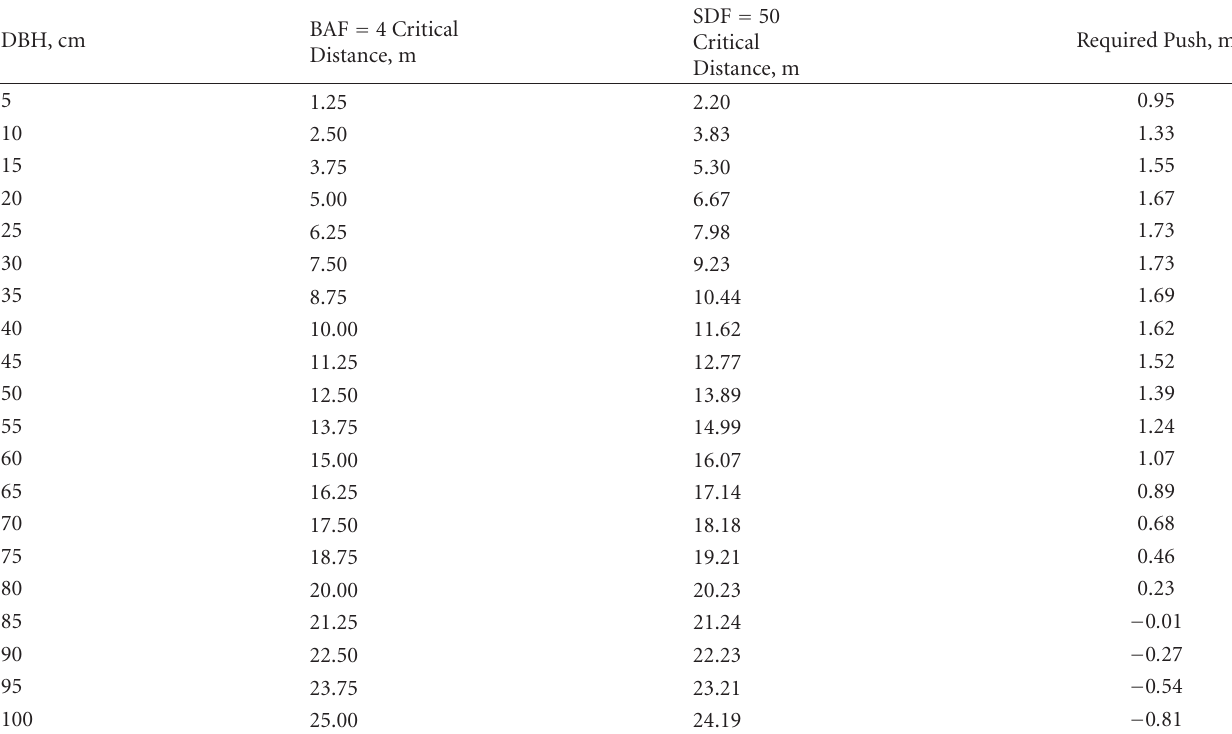
Figure 1: Area of the inclusion zone and limiting distance (or inclusion zone radius), for ordinary HPS with a BAF 4 m 2 /ha gauge and direct sampling for ASDI with a stand density factor of 50.